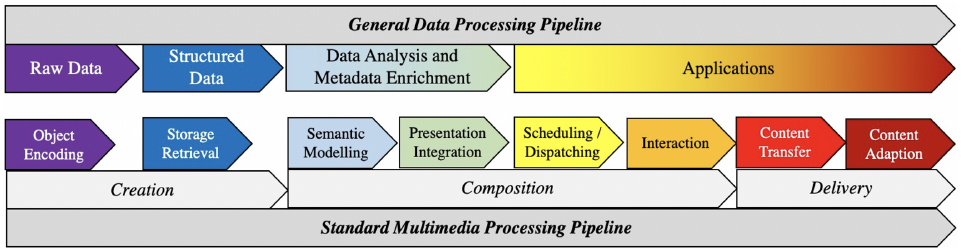
Figure 1. Mapping of the general data processing pipeline to the standard multimedia processing pipeline